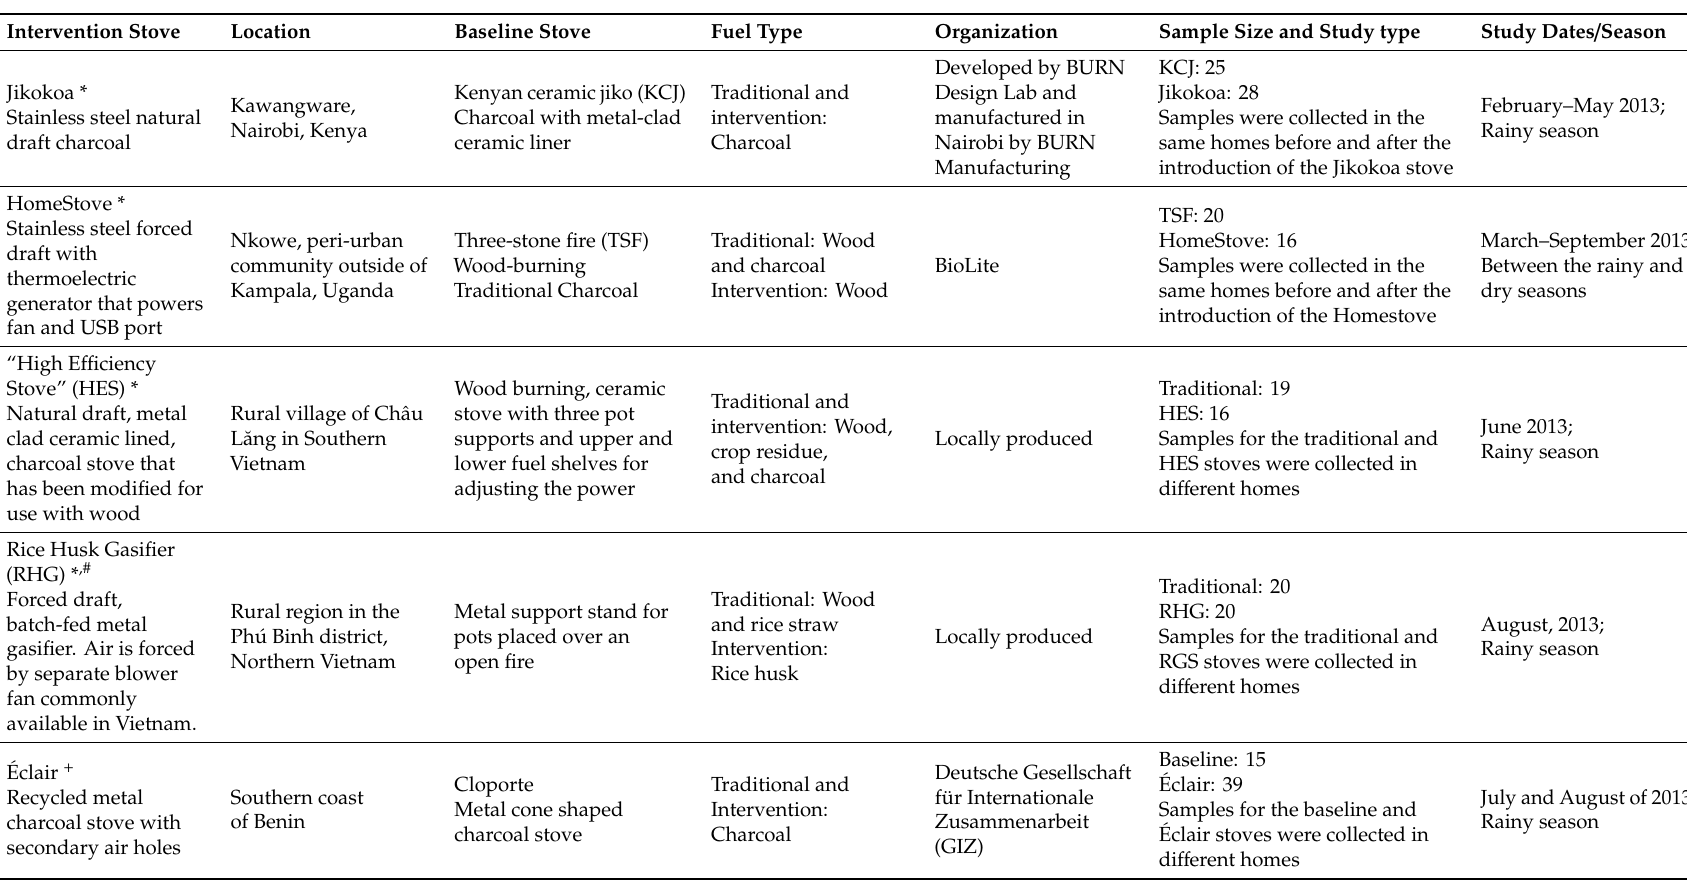
Table 1. Study stoves, locations, and details for the project sites. More details and pictures of the stoves can be found in supplementary